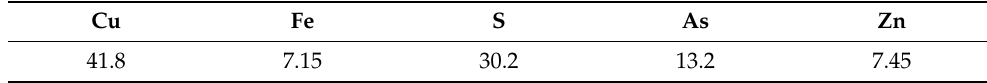
Figure 1. The XRD pattern of the minerals: Cu 12 As 4 S 13 ( A ), CuFeS 2 ( B ), ZnS ( C ) and FeS 2 ( D ). Table 1. Chemical composition of the synthetic concentrate (%).